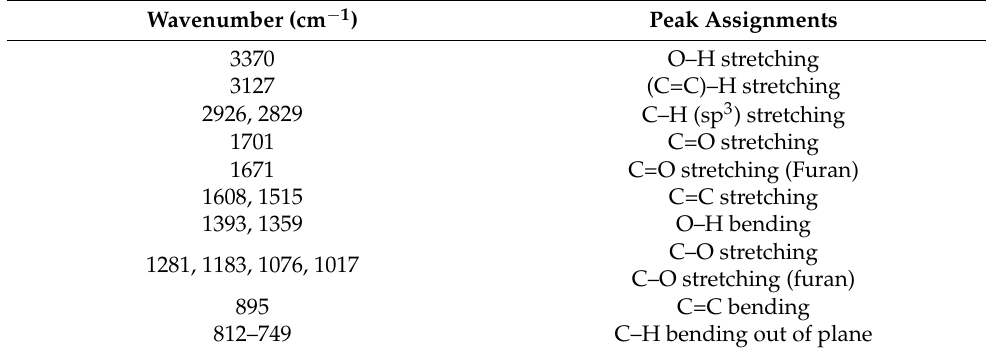
Figure 1. Chemical structures of the reactives employed: ( a ) Jeffamine D400, ( b ) Furfuryl Glycidyl Ether, ( c ) BMI689, ( d ) humins (adapted from [5]), ( e ) FT-IR spectra of Humins-DA and raw humins, and ( f ) humins complex viscosity modulus variation as a function of temperature. Table 1. Peaks assignments of humins FT-IR